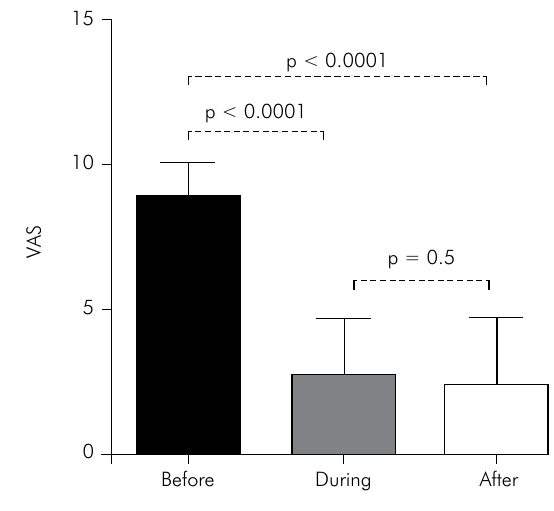
Figure 1. Mean ± SD of VAS values before, during, and after treatment (Student t test).